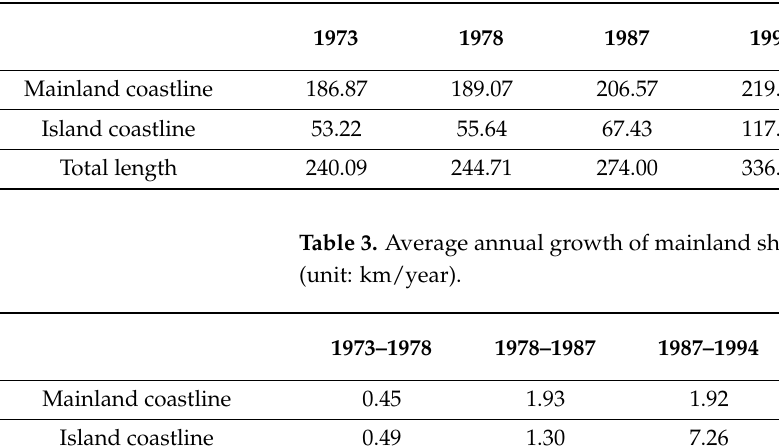
Table 2. Statistics of mainland shoreline and island coastline in Pearl River Estuary (unit: km).